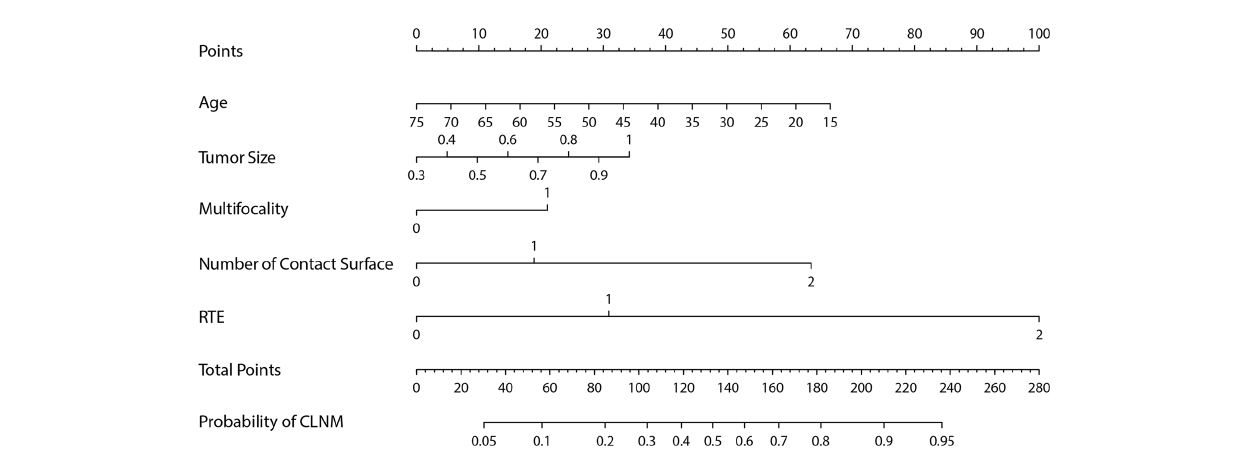
FIGURE 3 | The nomogram for predicting the central lymph node metastasis probability in cN0 papillary thyroid microcarcinoma patients.